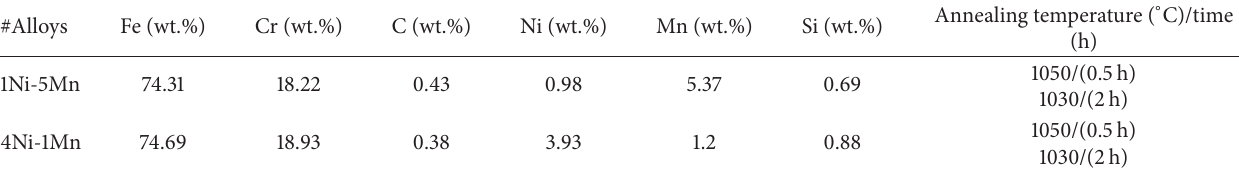
Table 1: Details of chemical composition and solution annealing conditions for four stainless steel alloys. #Alloys Fe (wt.%) Cr (wt.%) C (wt.%) Ni (wt.%) Mn (wt.%) Si (wt.%) 1Ni-5Mn 74.31 18.22 0.43 0.98 4Ni-1Mn 74.69